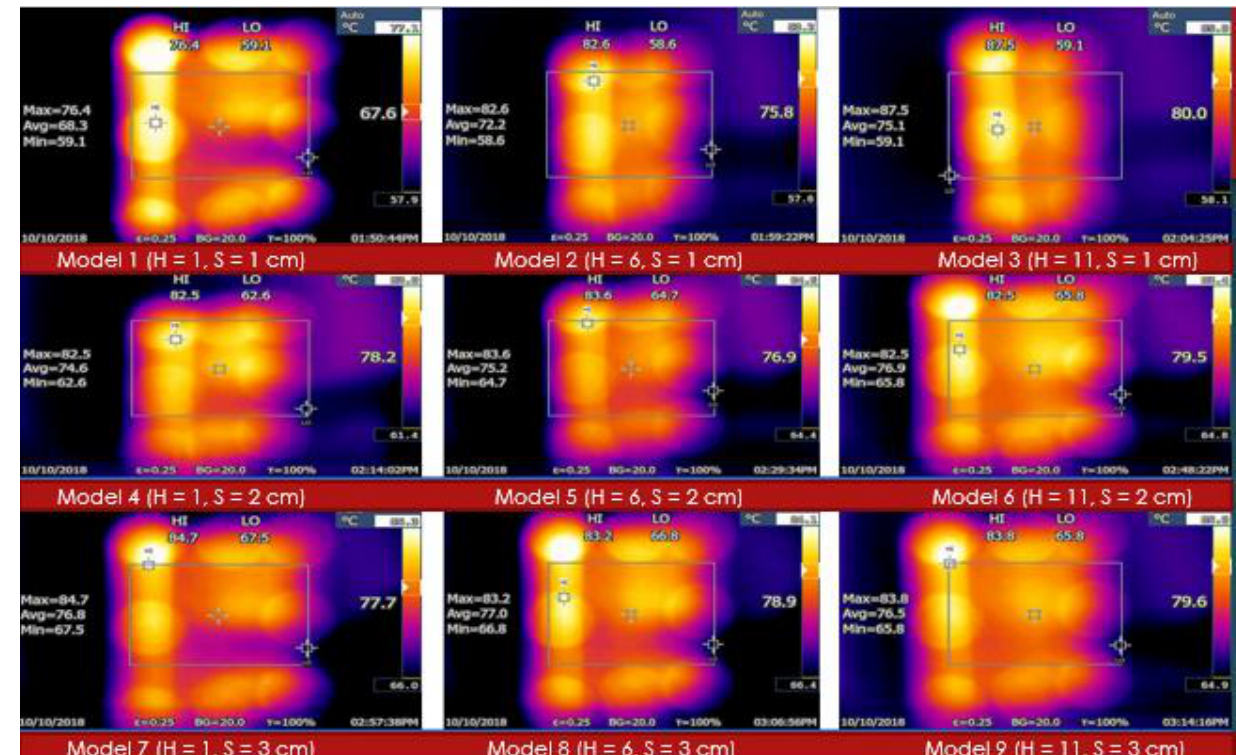
Figure 4. Thermographic distribution of aluminum flat plate model ( 1 ) to ( 9 ) at Re = 17,000.